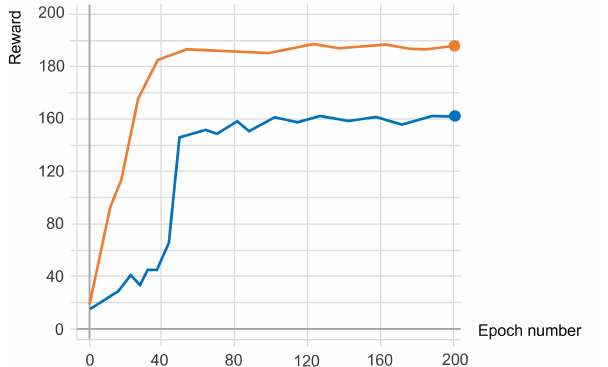
Figure 6. Comparison of the reward obtained by the agent with the same training configuration, when no IMU sensor is used (blue), using the IMU constraints (orange). The horizontal axis shows the training epoch number and the vertical axis shows the